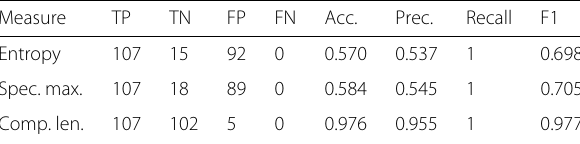
Table 1 Classification criteria performance evaluation